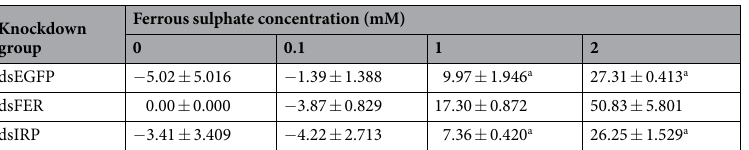
regulated cell death (RCD), ferroptosis 19 . In ferroptosis, the iron-catalyzed lipid peroxidases accumulates to toxic levels due to the inactivation of the phospholipid peroxidase 16,19 . Although ferroptosis has not been established in ticks, ferroptotic death can be hypothesized as the cause of ISE6 cell mortality, and this hypothesis warrants further investigation in biochemical tests.